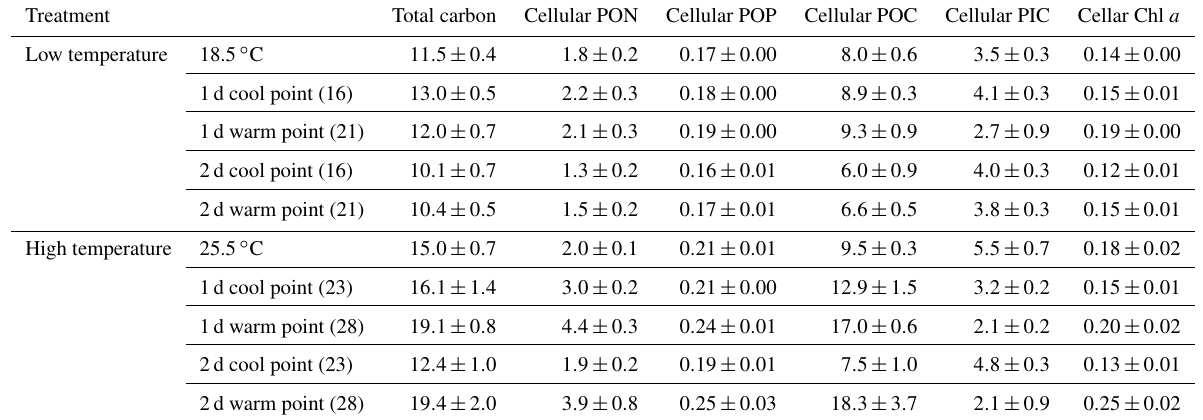
Table 1. The effect of temperature variation under low and high temperature on total carbon (pgcell − 1 ), cellular POC (pgcell − 1 ),